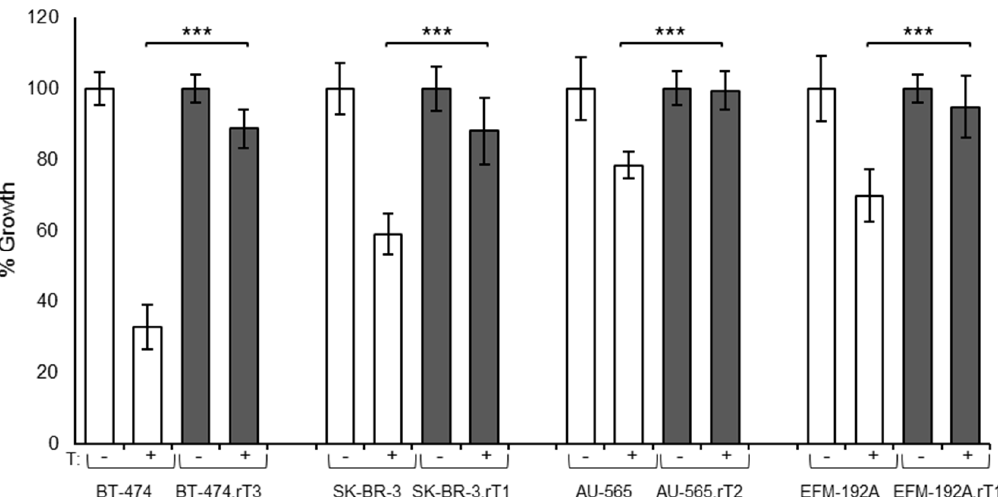
Figure 1. Characterisation of a panel of cell-line models of acquired trastuzumab resistance. Effect of trastuzumab treatment on sensitive and resistant cells. Proliferation was measured after seven days of treatment by trypan blue exclusion. T: Trastuzumab 15 µ g/mL. Data are expressed as mean ± SD from ≥ three independent experiments. *** denotes p ≤ 0.001.